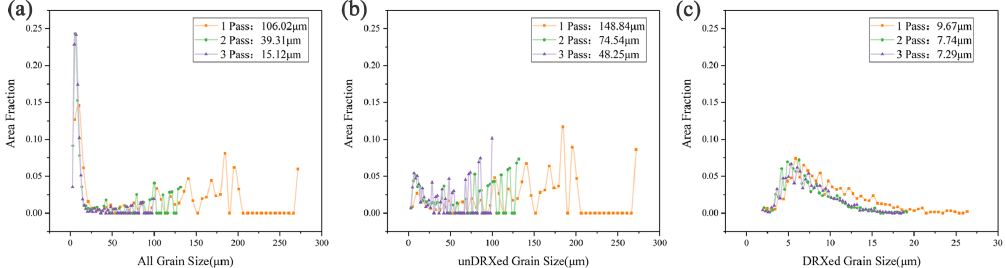
Figure 6. Grain size of the alloys under different MDFed passes: ( a ) all grains; ( b ) unDRXed grains; ( c ) DRXed grains.